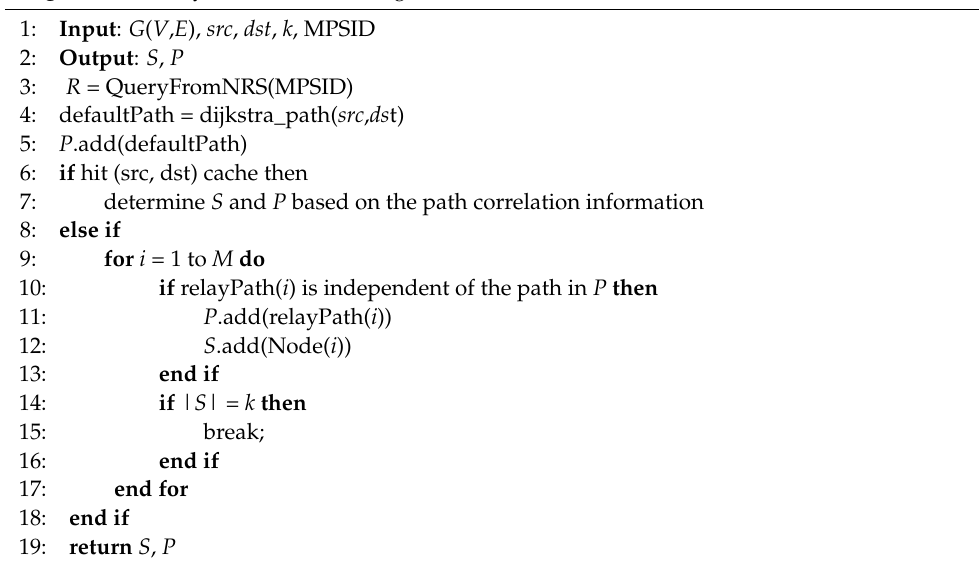
Algorithm 1 Relay-Node-Selection